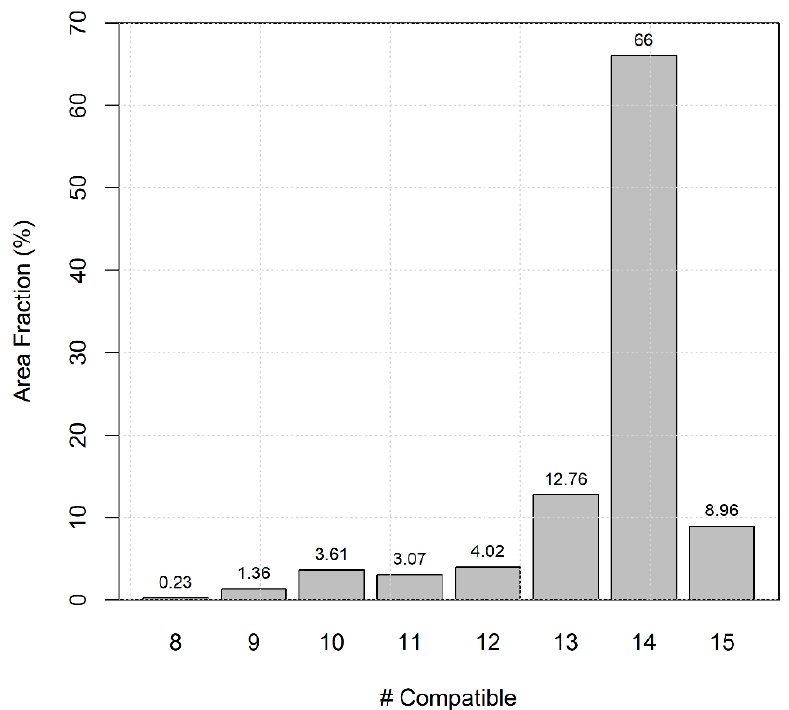
Figure 7. Area fraction of the number of compatible constituents within Dockum-HSU for gel-based hydraulic fracturing (HF).